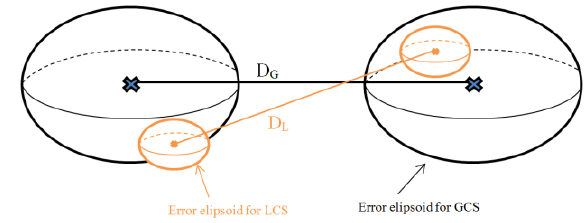
Figure 1. Objects selected for the research purpose – accuracy transfer